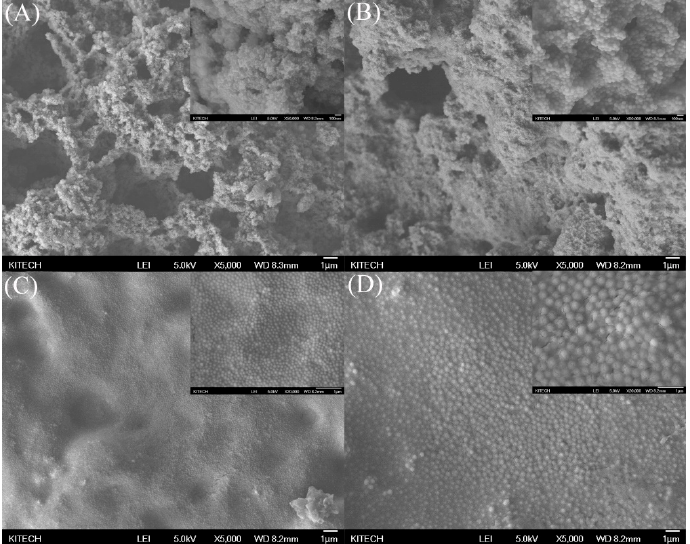
Figure 7. SEM images of spray-coated surfaces after heat treatment at 150 °C; ( A ) 12 nm- Figure7. SEMimagesofspray-coatedsurfacesafterheattreatmentat150 ◦ C;( A )12nm-SiO 2 (46)@PFMA, SiO 2 (46)@PFMA, ( B ) 80 nm-SiO 2 (49)@PFMA, ( C ) 150 nm-SiO 2 (47)@PFMA, and ( D ) 350 nm- ( B ) 80 nm-SiO 2 (49)@PFMA, ( C ) 150 nm-SiO 2 (47)@PFMA, and ( D ) 350 nm-SiO 2 SiO 2 (52)@PFMA.